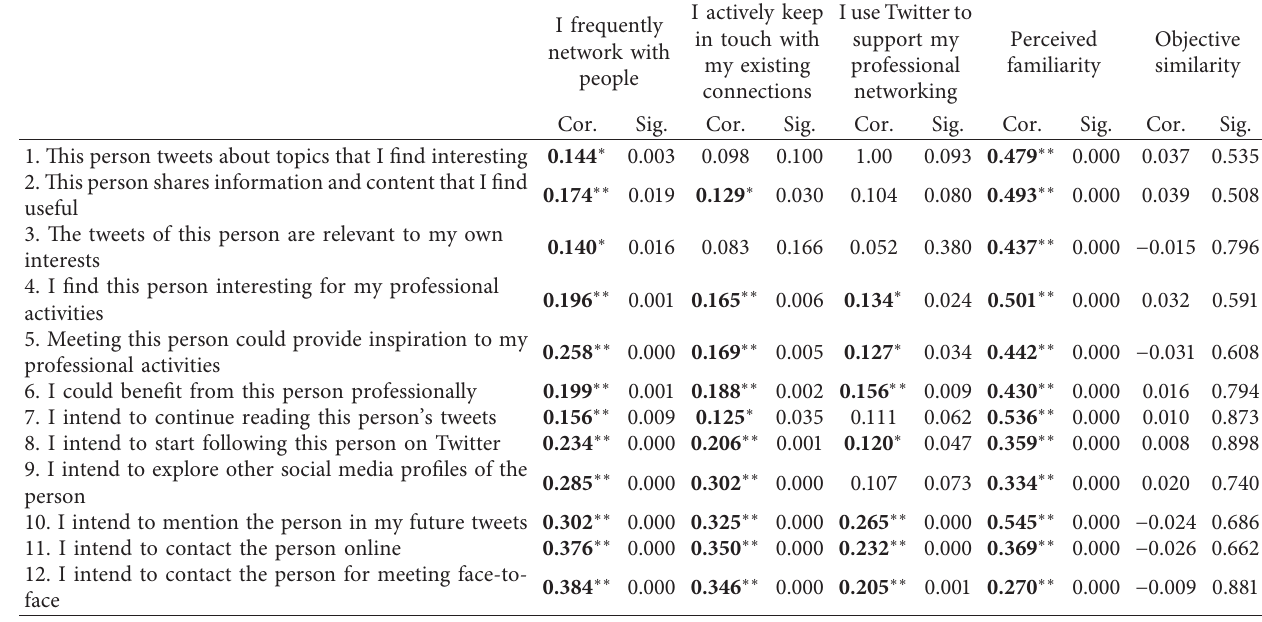
Table 3: The bi-variate spearman correlation test results between variables of subjective perceptions and selected background variables, perceived familiarity, and objective measures of